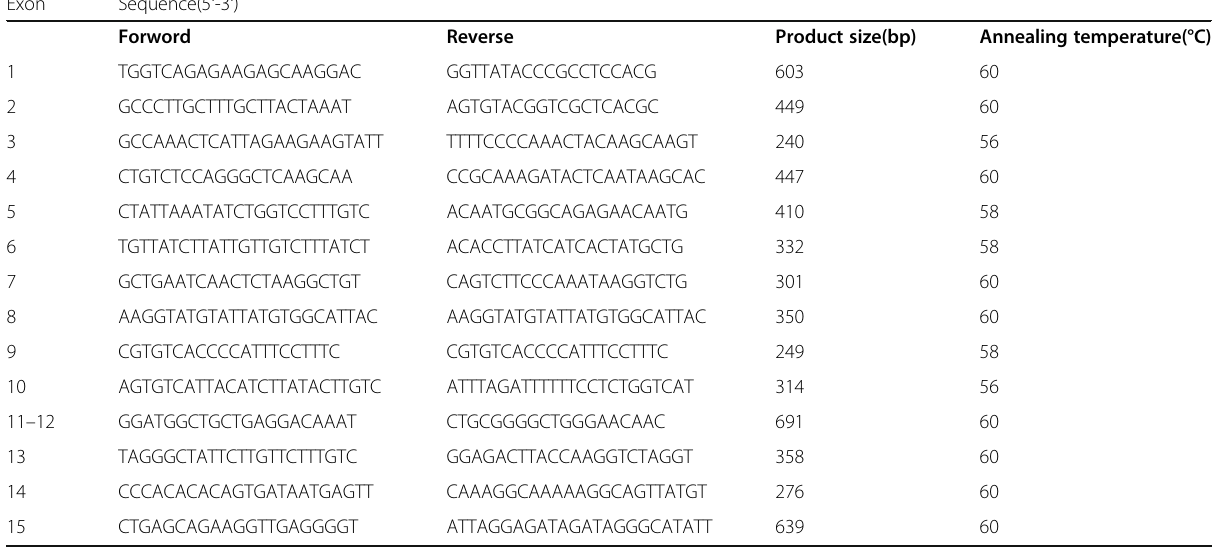
Table 3 PCR primers and conditions used for mutation analysis of the PCCB gene Exon Sequence(5 ′ -3 ′